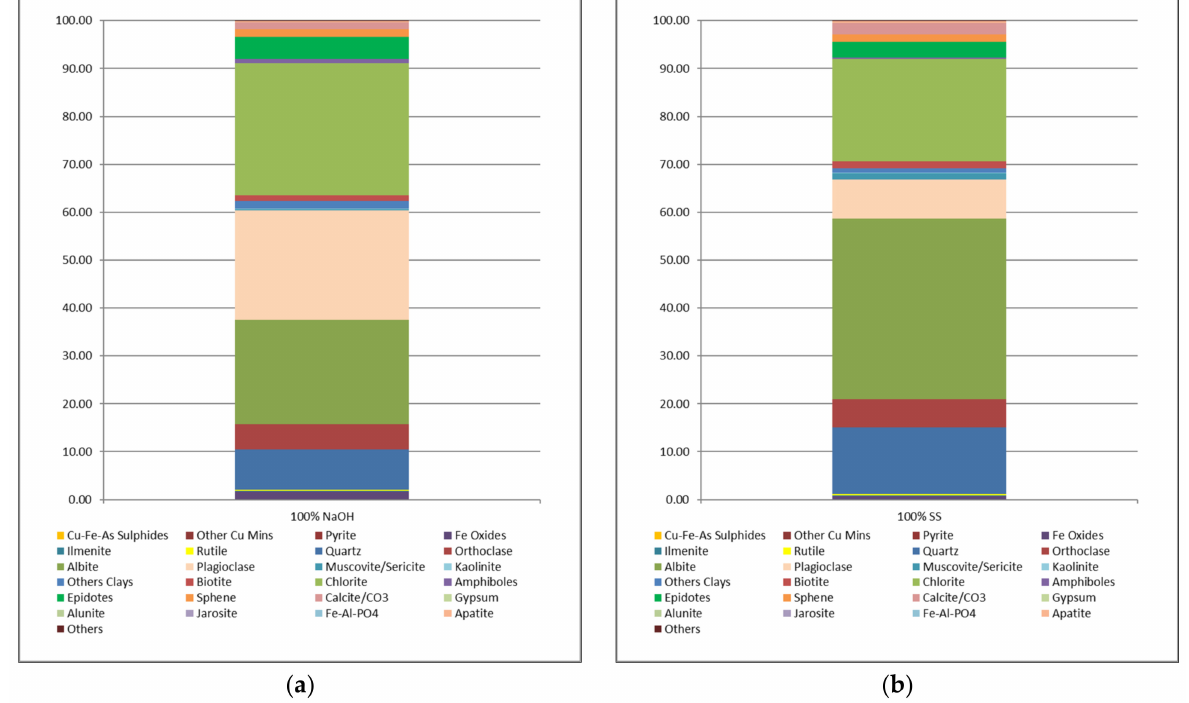
Figure 16. Modal mineralogy of the geopolymers activated with ( a ) 100% NaOH and ( b ) 100% SS. From the results, it was found that the geopolymer activated with 100% NaOH was mineralogically composed mainly of chlorite (27.55%), plagioclase (22.90%), and albite (21.77%), in addition to quartz (8.47%), orthoclase (5.24%), and epidote (4.58%). On the other hand, the activated geopolymer with 100% SS presented a different mineralogical composition, composed mainly of albite (37.71%) and chlorite (21.38%), and to a lesser extent, quartz (14.04%), plagioclase (8.13%), and orthoclase (5.89%). Figure 17 shows the images obtained for the mineralogical analysis performed (a) for the geopolymer activated with 100% NaOH and (b) for the geopolymer activated with 100%